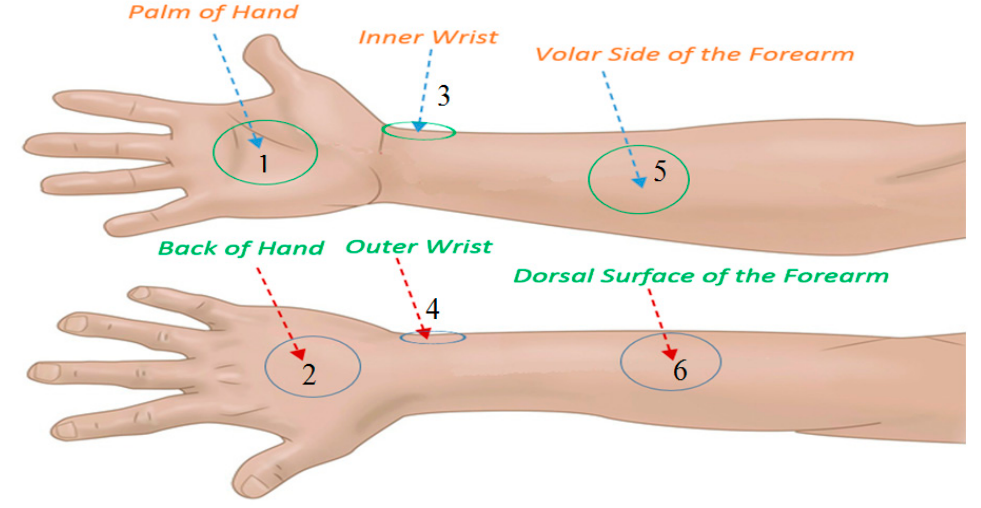
Figure 2. Six regions on the arm where the reflectance of the skin is measured.